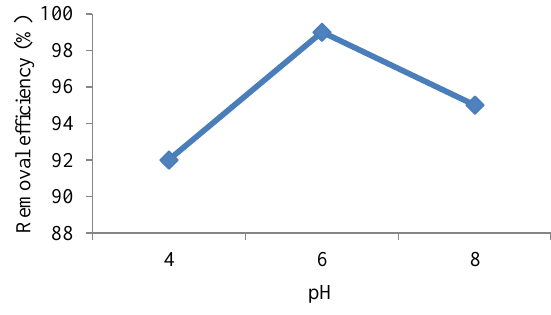
Fig. 4. The removal efficiency based on the pH (the optimum adsorbent level 3 gr and balance time of 3h and optimum adsorbate concentration of 15